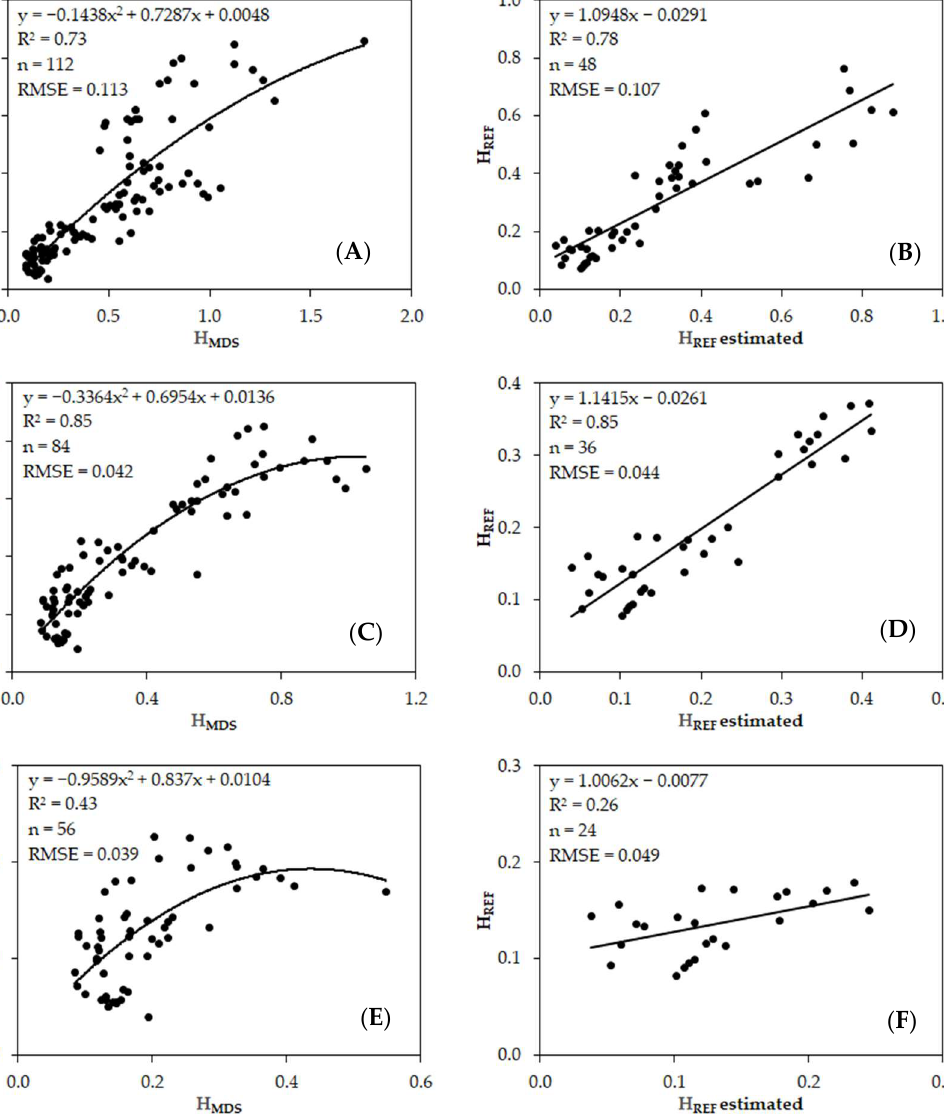
Figure 4. ( A , C , E ): Regression models between H REF and H DSM using modeling dataset for all stages, the flowering stage, and the booting stage respectively; ( B , D , F ): performance of the regression models with the validation dataset for all stages, the flowering stage, and the booting stage, respectively. RMSE = root mean square error (m), n = number of observations. For all models p < 0.05.